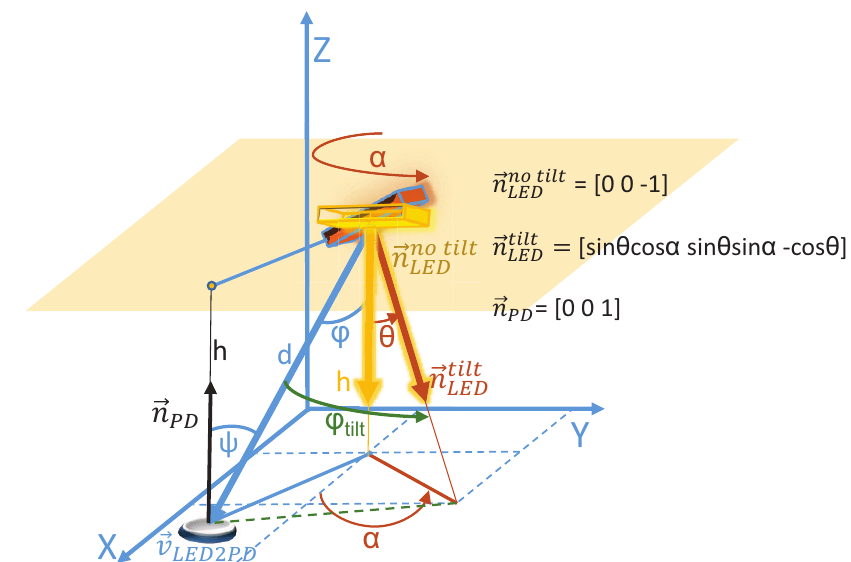
Figure 2. Overview of visible light